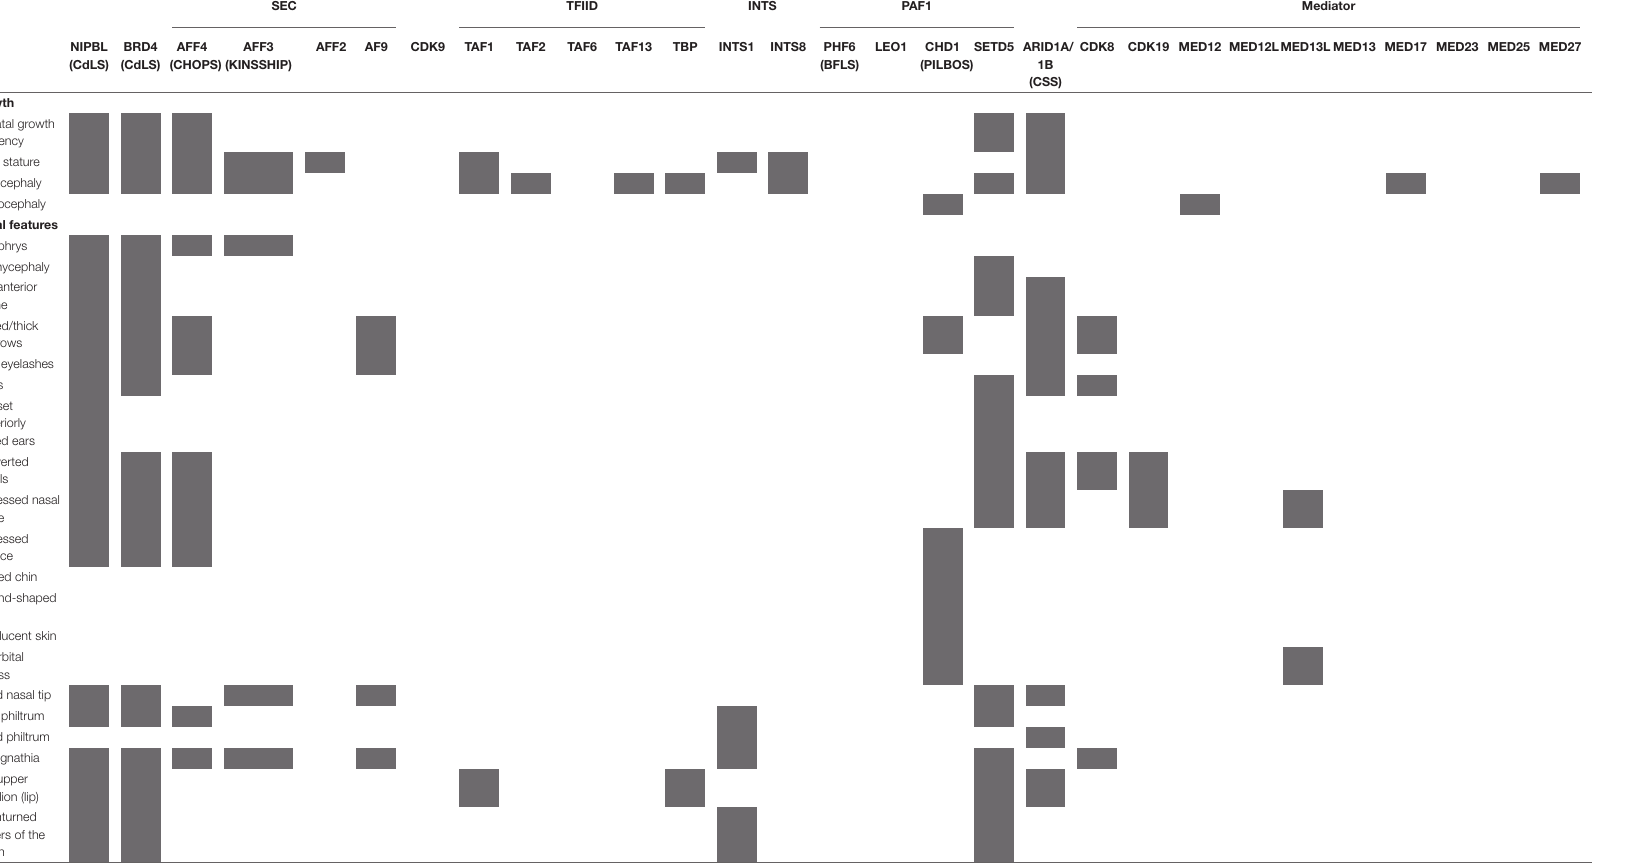
Growth Prenatalgrowth deficiency Shortstature Microcephaly Macrocephaly Facialfeatures Synophrys Brachycephaly Lowanterior hairline Arched/thick eyebrows Longeyelashes Ptosis Lowset posteriorly rotatedears Anteverted nostrils Depressednasal bridge Depressed midface Pointedchin Almond-shaped eyes Translucentskin Periorbital fullness Broadnasaltip Longphiltrum Broadphiltrum Micrognathia Thinupper vermilion(lip) Downturned